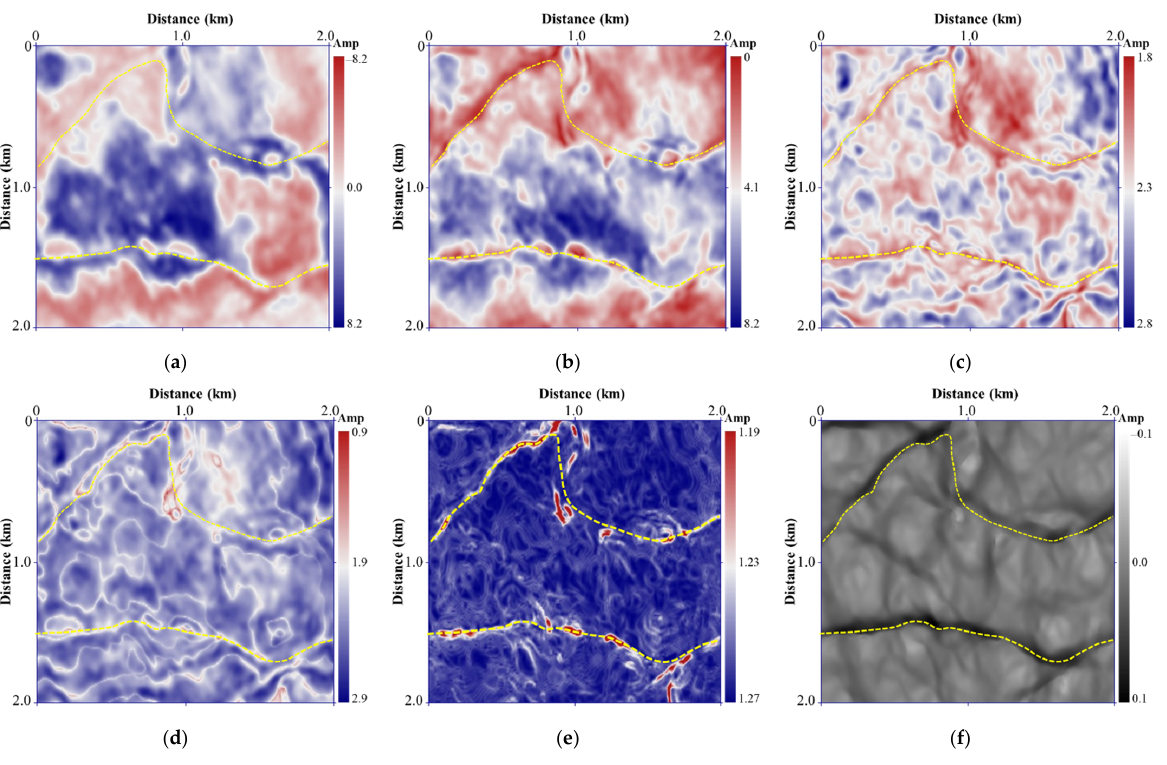
Figure 7. Time slices at 1.7s with two interpreted channels: ( a ) amplitudes; ( b ) instantaneous amplitudes; ( c ) instantaneous amplitudes obtained by GHT with p = 6; ( d ) instantaneous amplitudes obtained by LTFS with p = 6, f 1 = 0 Hz, and f 2 = 90 Hz; ( e ) most positive curvatures; ( f ) third-generation coherences (C3).